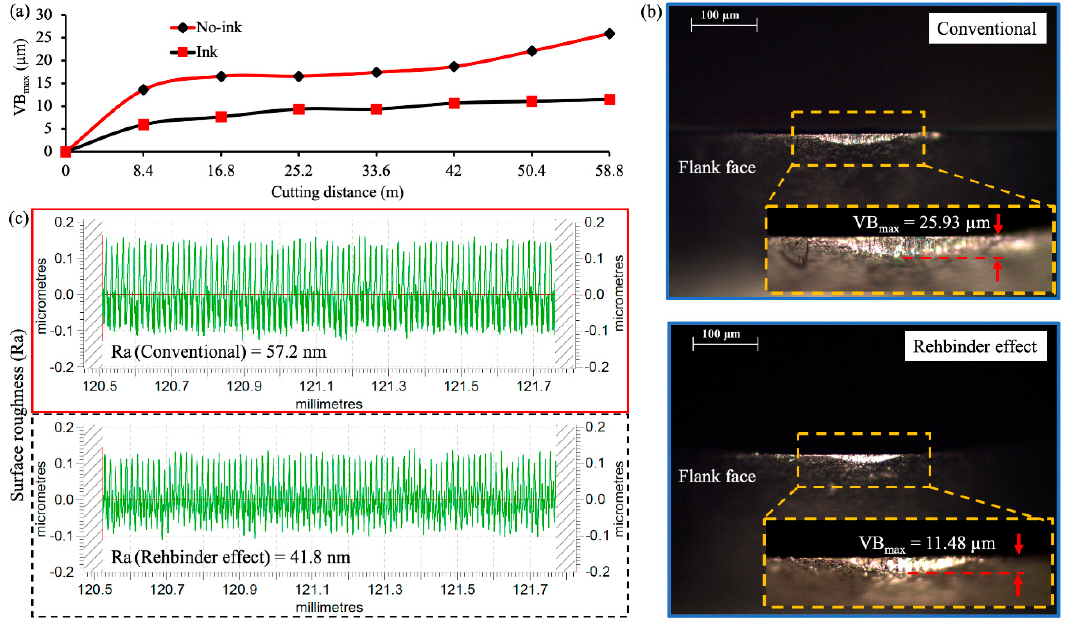
Figure 5. ( a ) Wear land (VB max ) progression of the polycrystalline diamond (PCD) turning of iron; ( b ) the arithmetic mean height (Ra) of after cutting a distance of 58.8 m with and without ink; and ( c ) optical the imaging of the corresponding tool wear land.